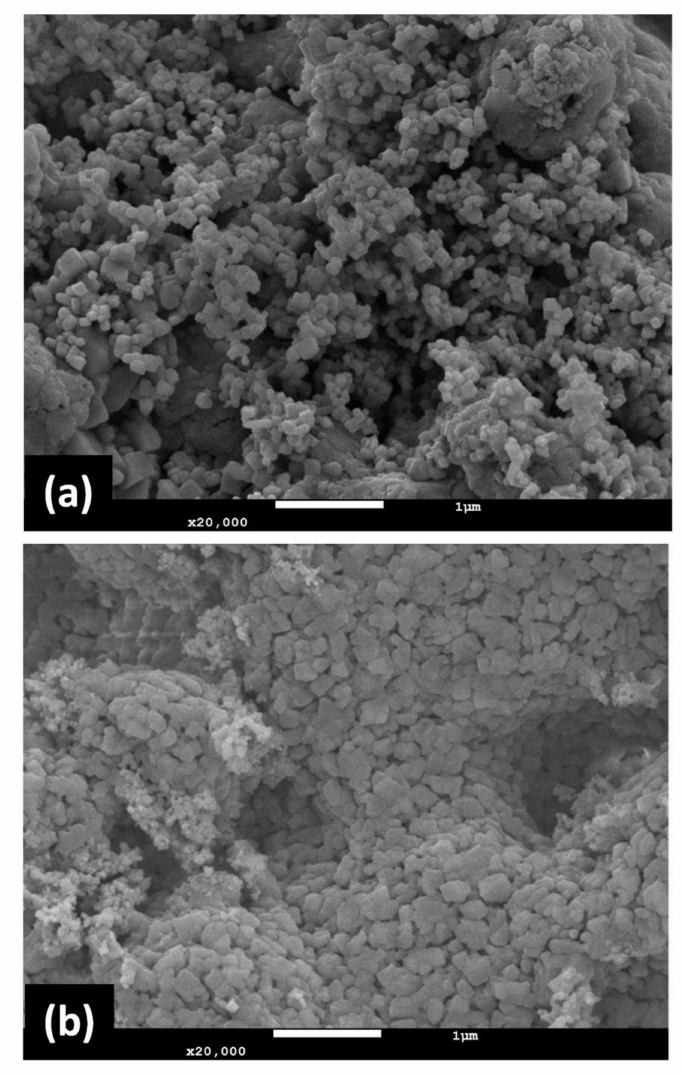
Figure 7. SEM images of CaTi-3 ( a ) and CaTi-5 ( b ) after 20 cycle